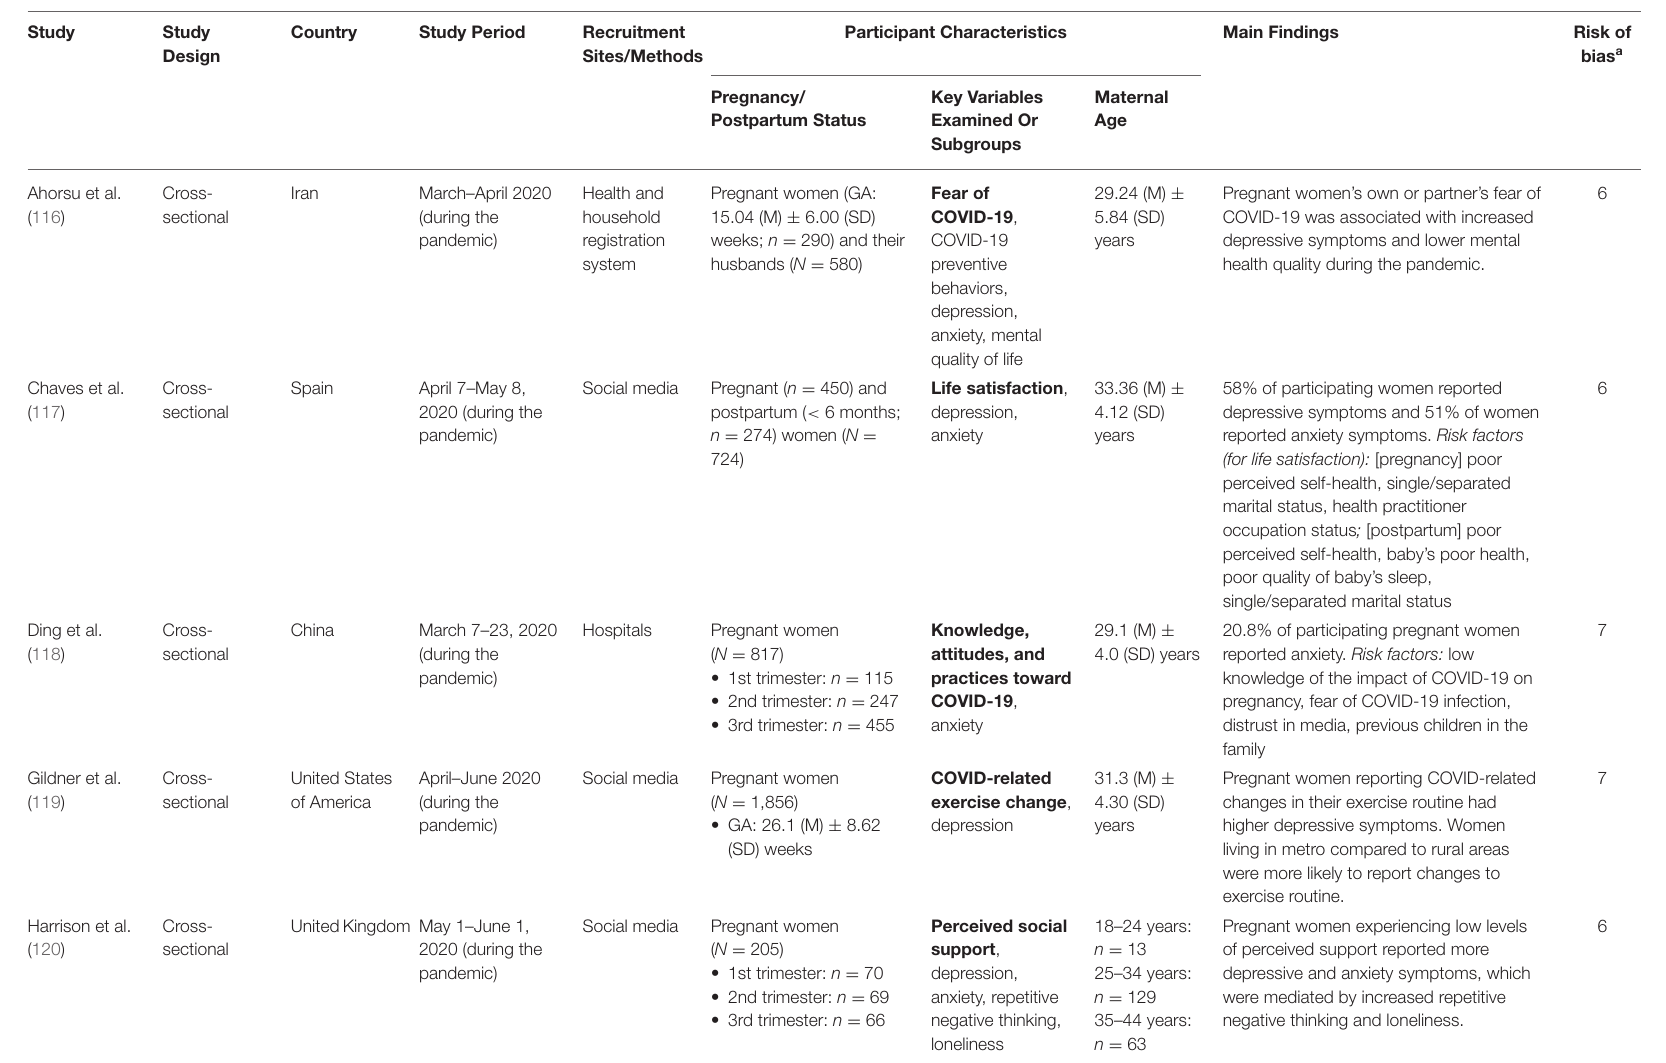
TABLE 8 | Perinatal mental health outcomes during COVID-19 as a function of factors not examined